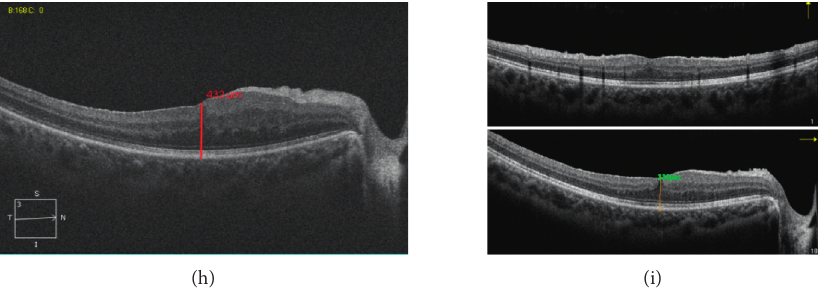
Figure 1: Right eye of a 30-year-old woman with vasoproliferative tumor of the retina and an epiretinal membrane (Case 9). Fundus fluorescein angiography (FFA): (a) (35.93 seconds) two tortuous and dilated blood vessels (feeder and draining vessels) were observed around the tumor. The early filling of the tumor was conspicuous. (b) (46.59 seconds) No perfusion areas around the fundus were observed. (c) (4 minutes 56.43 seconds) The apparent fluorescence leakage could be observed in the retina. Fundus photograph: (d) before treatment, the epimacular membrane was located in the temporal side of optic disc and an orange-red hemorrhagic mass sized 1.5 optic disc diameter (PD) could be observed in the temporal periphery. The best-corrected visual acuity (BCVA) was 0.7 logMAR. (e) One week after treatment with cryotherapy, laser spots were visible around the temporal retina. The peripheral retinal mass was fibrotic and yellowish. Feeder vessels were narrowed. (f) One month after treatment with cryotherapy, the tumor was regressive and surrounded by laser spots. BCVA was 0 logMAR. Spectral-domain optical coherence tomography (SD-OCT): (g) before treatment, the retinoschisis was caused by the epimacular membrane. The central retinal thickness (CRT) was 555 μ m. (h) One week after treatment, the retinal morphology was abnormal with macular edema. The CRT was 432 μ m. (i) One month after treatment, the retinal morphology was significantly improved. Mild edema and thickened retinal nerve fiber layers were shown in the SD-OCT. The CRT was 338 μ